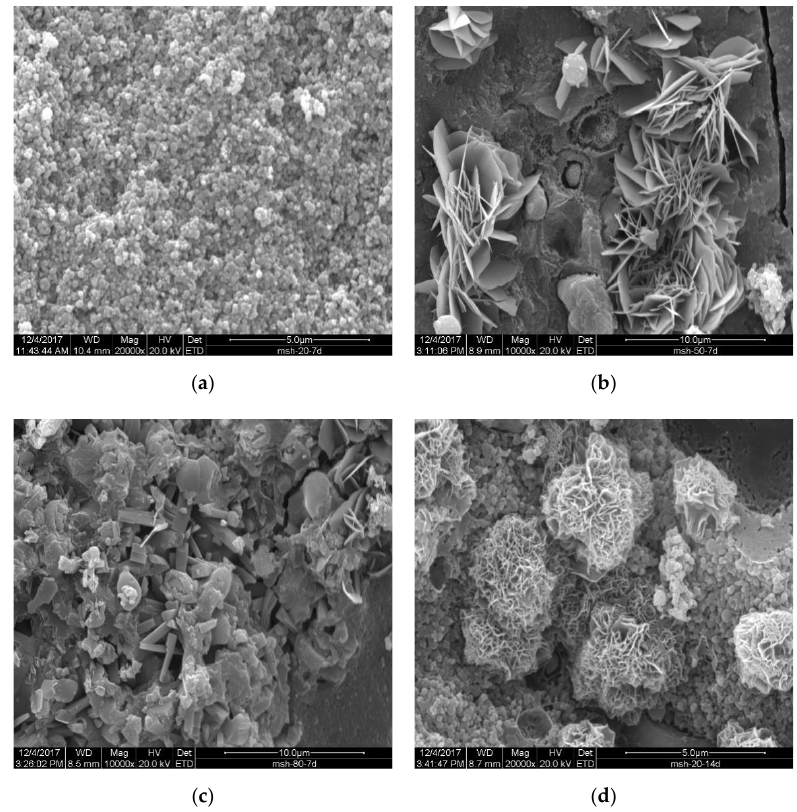
Figure 19. SEM image of samples prepared using MgO calcined for 2 h: ( a ) cured in 20 °C water for 7 d; ( b ) cured in 50 °C water for 7 d; ( c ) cured in 80 °C water for 7 d; and ( d ) cured in 20 °C water for 14 d.